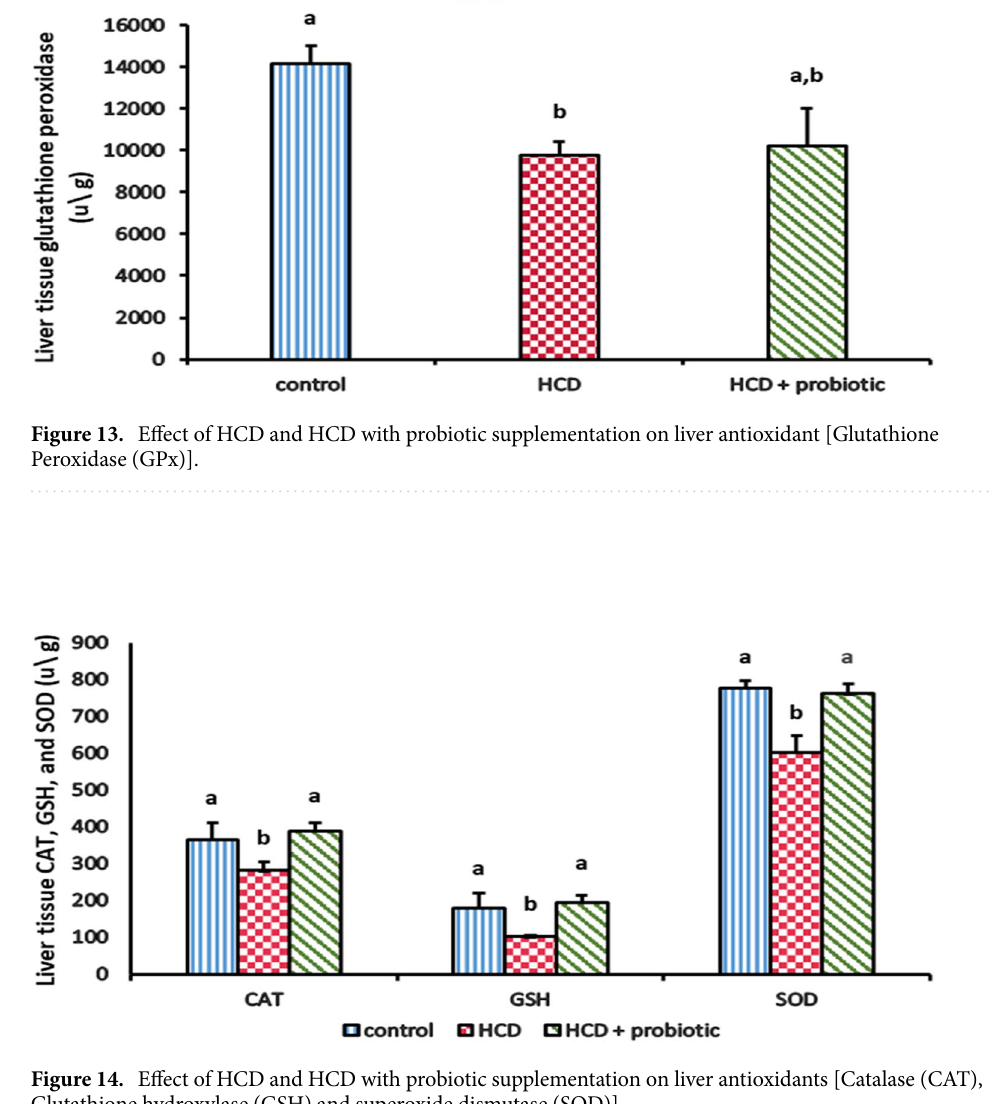
Figure 14. Effect of HCD and HCD with probiotic supplementation on liver antioxidants [Catalase (CAT), Glutathione hydroxylase (GSH) and superoxide dismutase (SOD)].